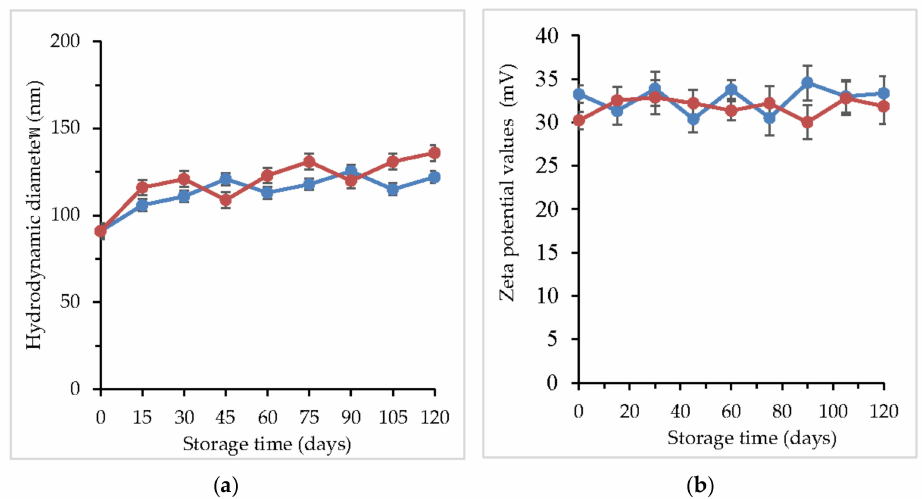
Figure 7. Sizes of CL-loaded NBSCh micelles following redispersion of powders in distilled water ( a ). Zeta-potential values of the CL-loaded NBSCh micelles freeze-dried powders during storage ( b ) stored at 4 ◦ C ( • ) and 30 ◦ C ( • ) for 120